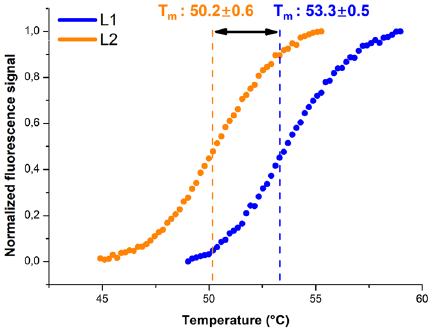
Figure 2. Thermal melting temperatures of L1 and L2. Transition mid-points (T m values) from fluorescent thermal melt assays were calculated by Hill equation fit. The assay was repeated 3 times.